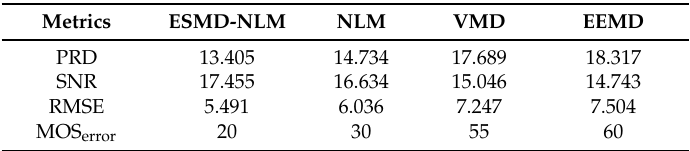
Table 2. The PRD, SNR, RMSE and MOS error values for the ESMD-NLM, NLM, VMD and EEMD methods operating on the simulated ECG signal corrupted with muscle artifact noise.